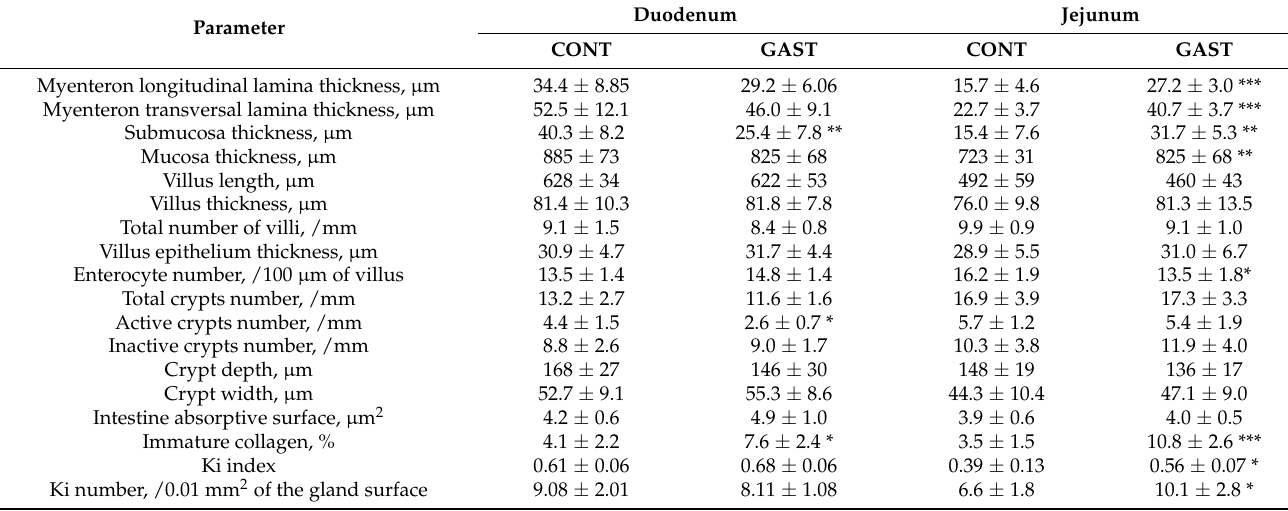
Table 1. The histomorphometrical parameters of the duodenum and jejunum in male Wistar rats in the CONT (sham- operated) and GASTR (subjected to gastrectomy) groups.